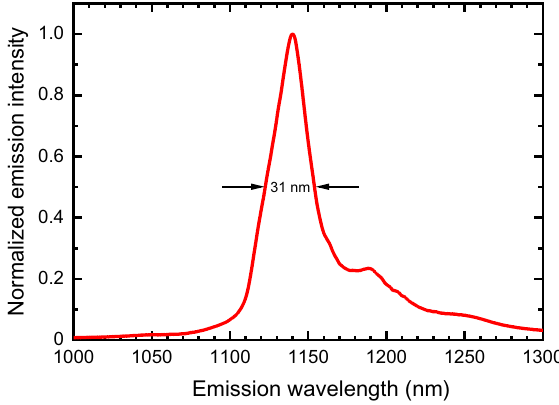
Figure 3. Emission spectrum for the specimen of Fig. 1, excited at 660 nm.